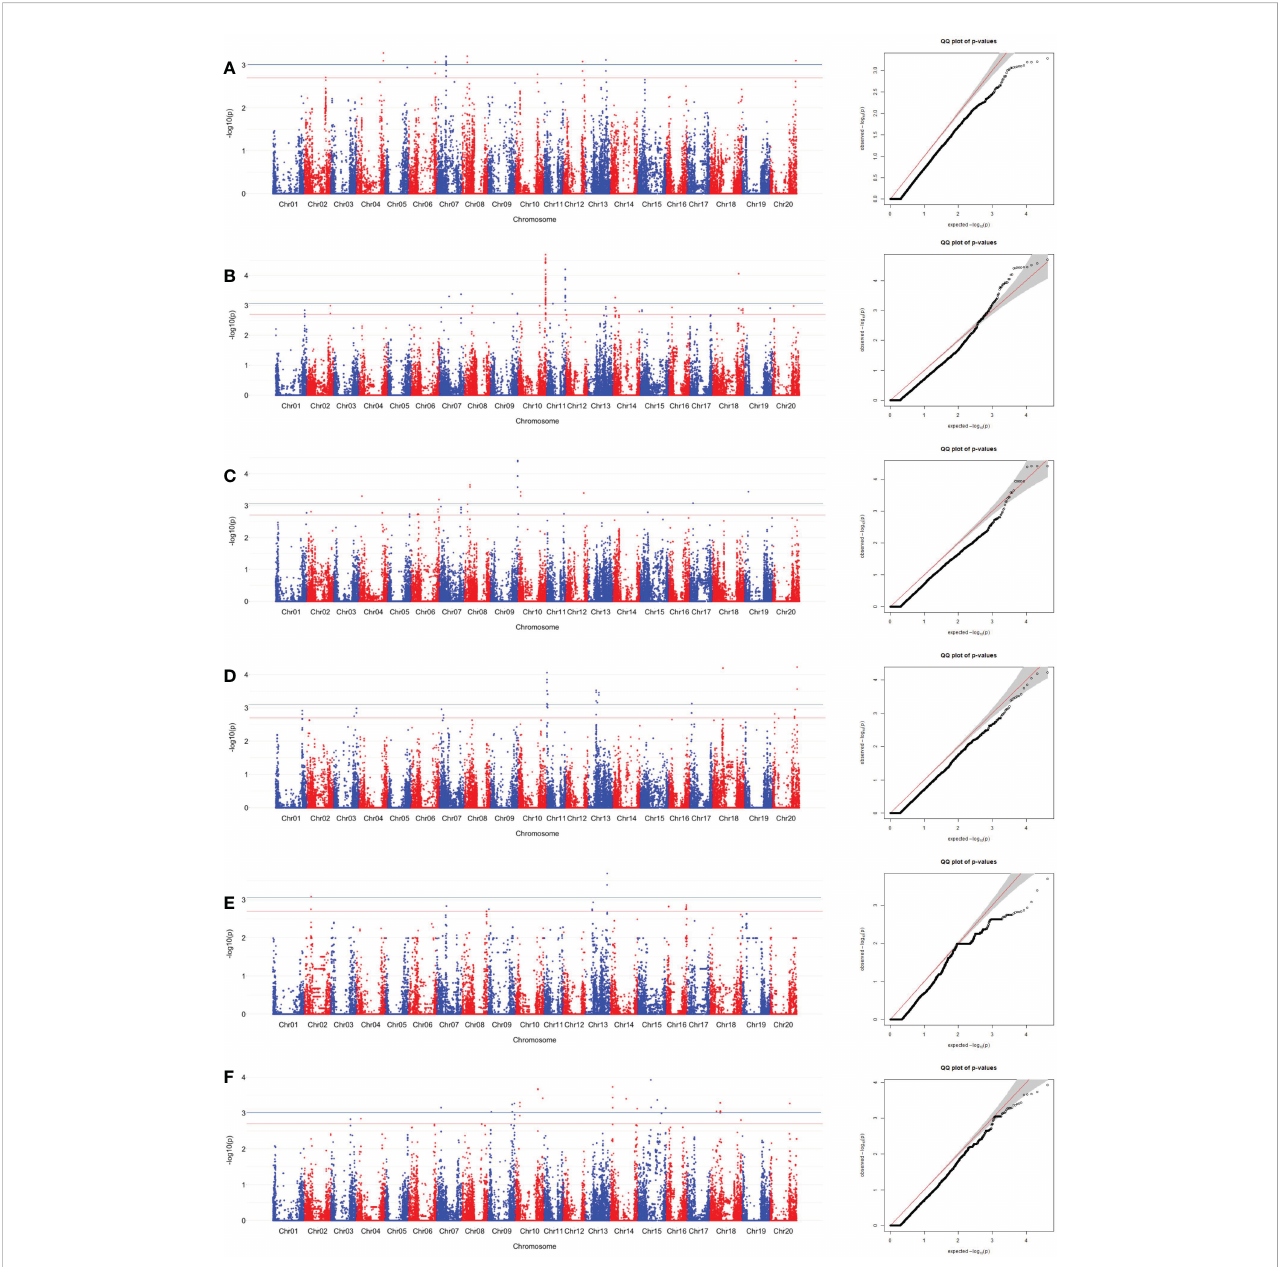
FIGURE 4 SNP associations for sucrose content in edamame beans harvest from (A) Blacksburg, VA, 2018, (B) Blacksburg, VA, 2019, (C) Portageville, MO, 2018, (D) Portageville, MO, 2019, (E) Fayetteville, AR, 2018, (F) Fayetteville, AR, 2019, are displayed in Manhattan plots with chromosomes in alternating colors, signi fi cance thresholds-log10(P) > 3.01 (the blue line) and suggestive threshold-log10(P) > 2.70 (the red line). Each respective QQ plot displays observed- log10(P) against